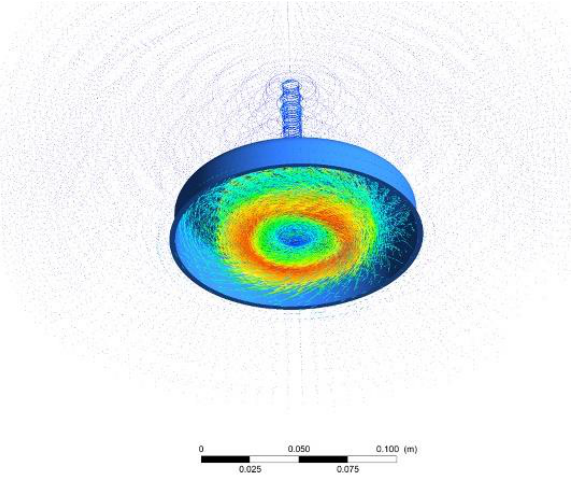
Figure 6. Simulation nephogram of flow velocity of water in the vortex